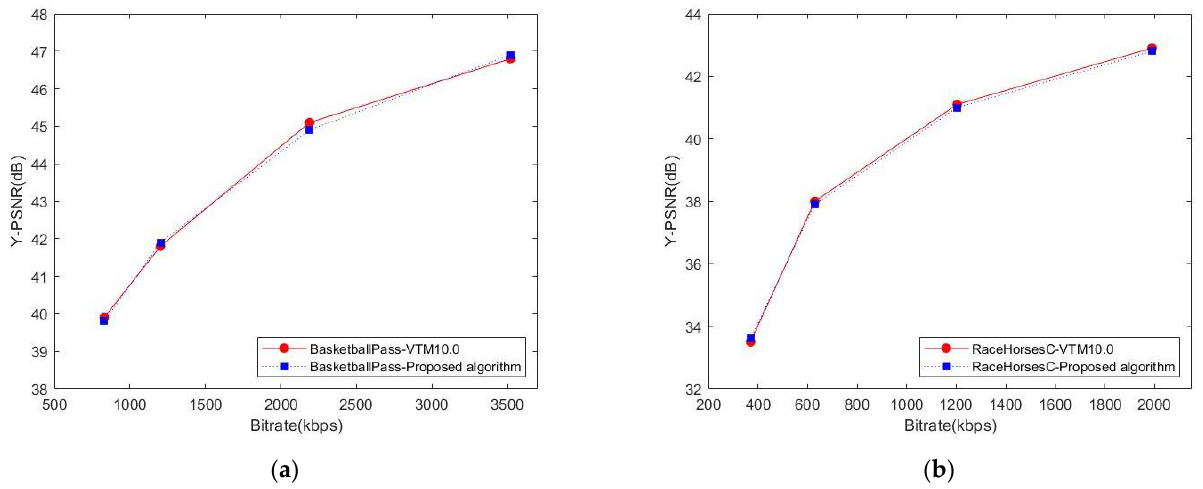
Figure 6. RD performance comparison chart of the proposed algorithm. ( a ) RD of the BasketballPass; ( b ) RD of the RaceHorsesC.